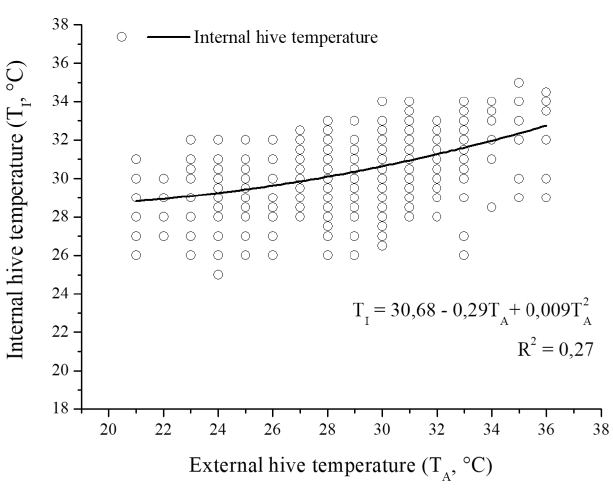
, °C) of the control group as a I , °C). A